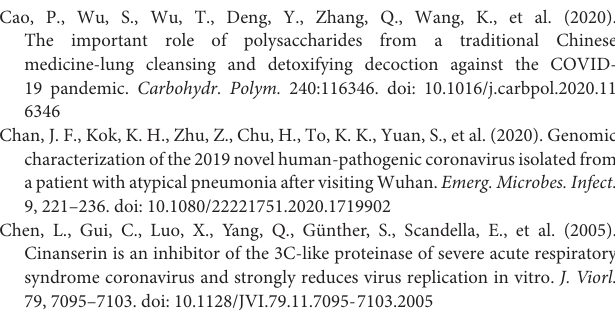
FIGURE S1 | The superpose structure of COVID-19 3CLpro (gray) and SARS-3CLpro (green). The catalytic dyad (His41 and Cys145) are shown as sticks. TABLE S1 | The AUC score of fivefold cross-validation. TABLE S2 | Analyzed results of six selected